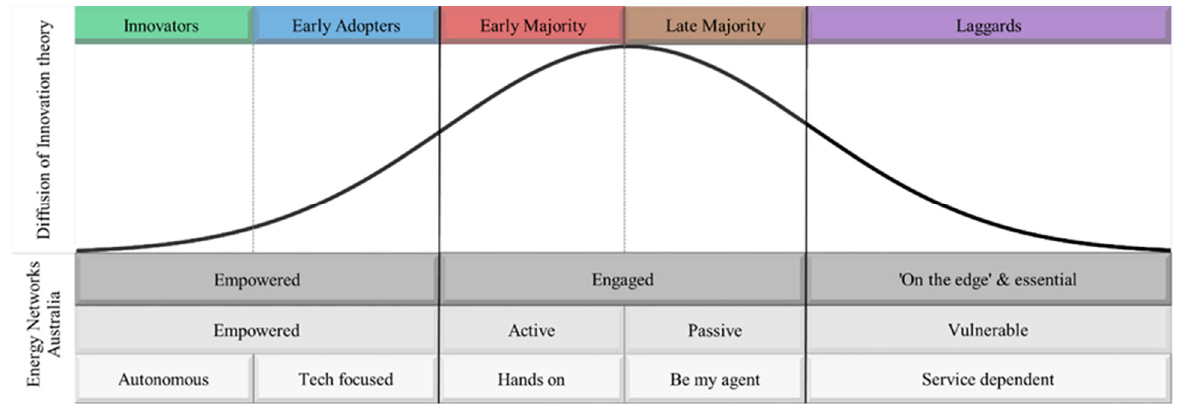
Figure 2. The categorisation of individuals by DoI [12], and Australian households by Energy Networks Australia [13].